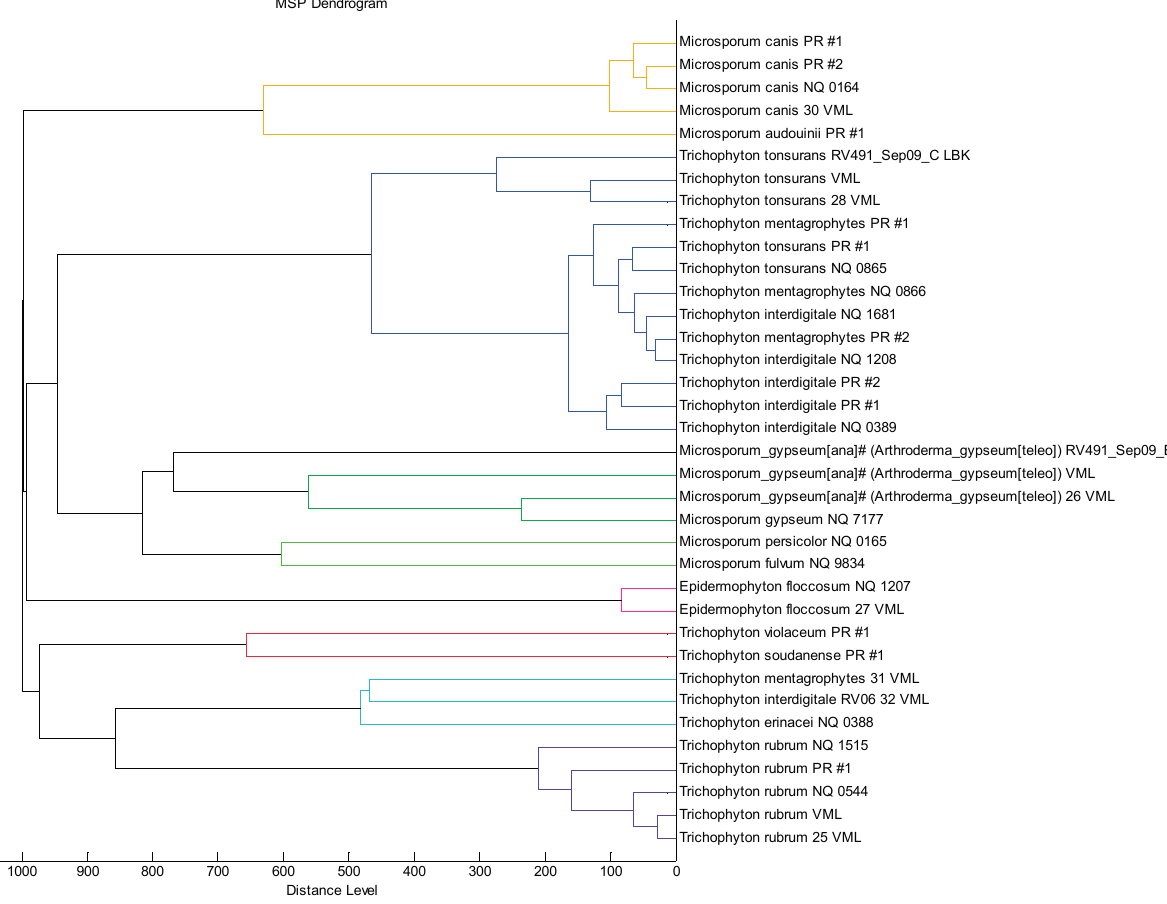
Figure 3. “Main spectra profiles”-based dendrogram of the 12 proteic profiles already included in Bruker Daltonics Database and 24 dermatophytes strains supplemented in the new in-house